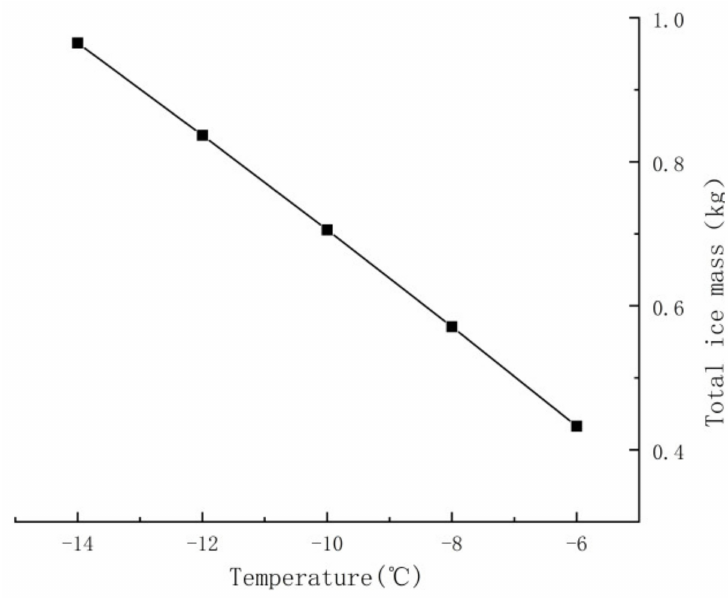
Figure 10. The changes of total ice mass at different